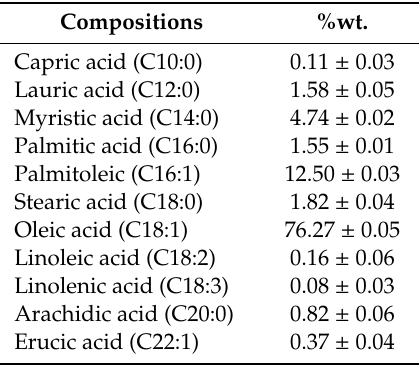
Table 1. Fatty acids compositions of RPO.